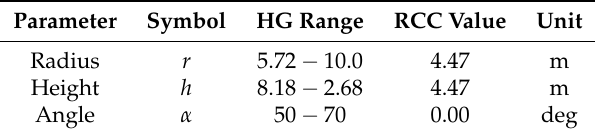
Figure 6. Hourglass nonlinear geometry WEC design. Table 1. Hour-glass (HG) and RCC buoy geometric